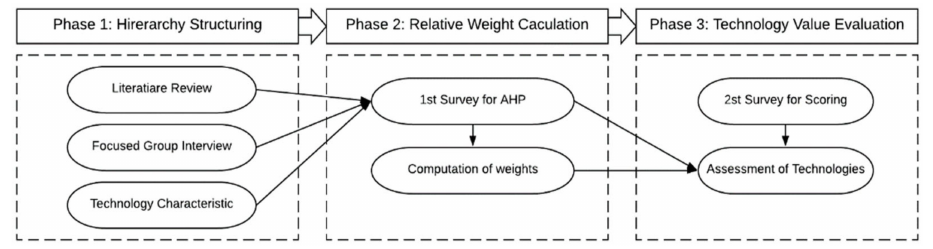
Figure 3. Research